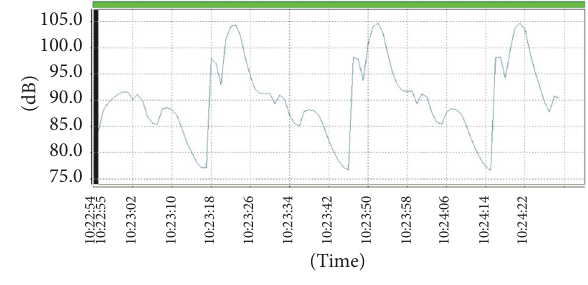
Figure 1: Equivalent sound